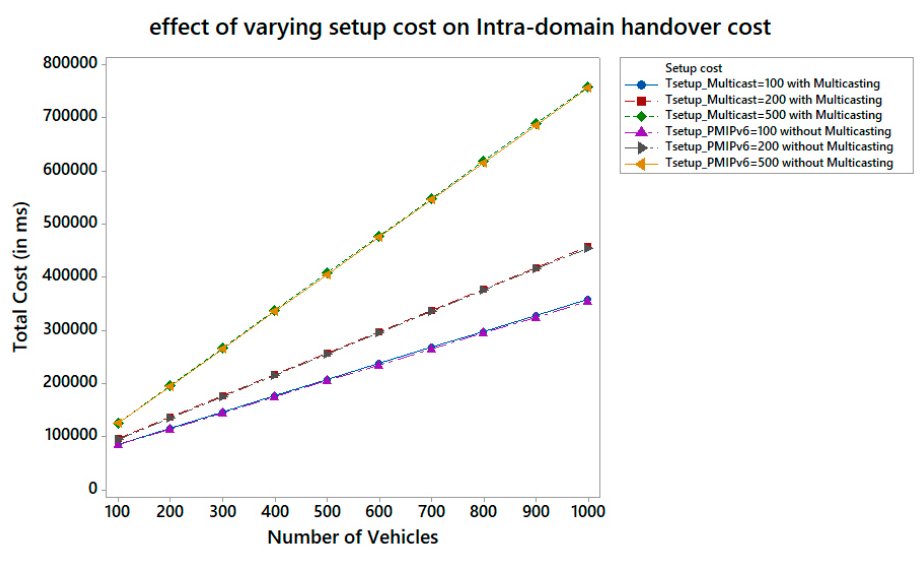
Figure 6. Effect of varying setup cost on intra-domain handoff.